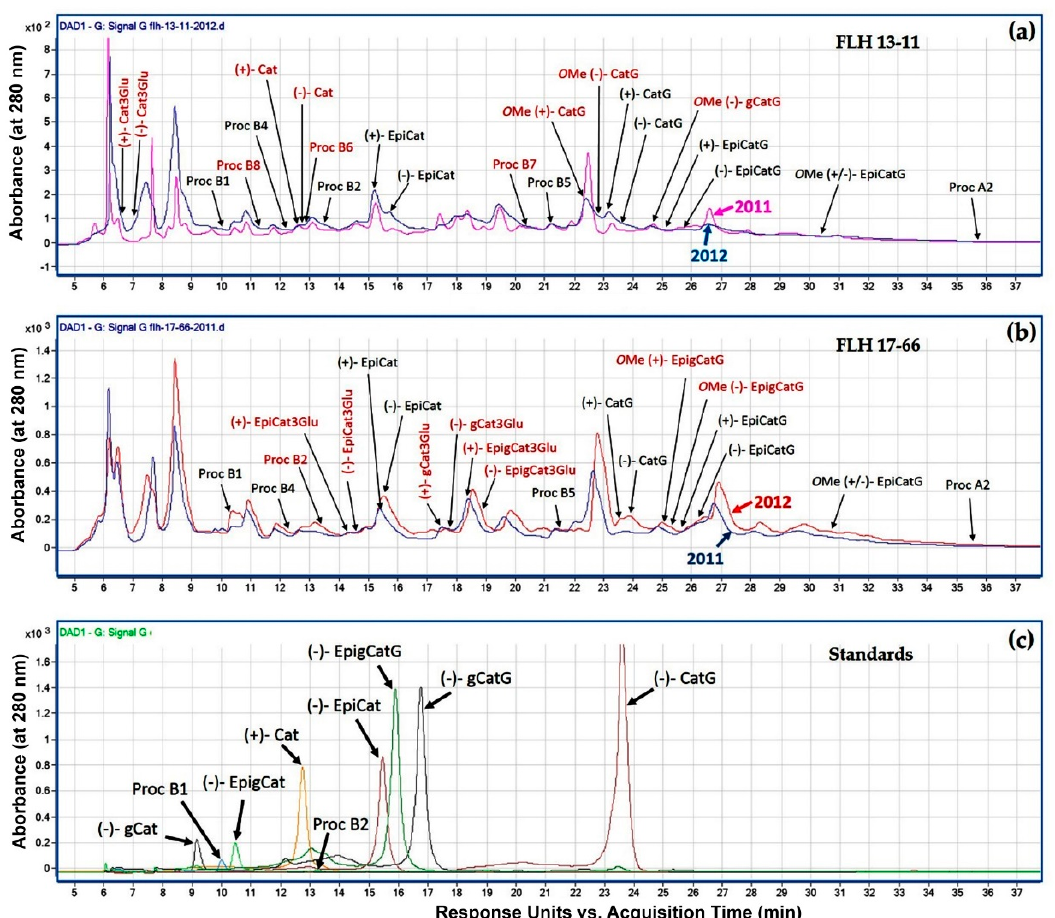
Figure 2. Comparison of metabolite peak profiles between berry extracts of FLH 13-11 and FLH 17-66 in two years and nine standards. Metabolite peaks detected by HPLC were recorded at 280 nm. ( a ) Two chromatograms show peaks annotated to be flavan-3-ols and dimeric PAs in berries of FLH 13-11 from the 2011 and 2012 cropping years. ( b ) Two chromatograms show peaks annotated to be flavan-3-ols and dimeric PAs in berries of FLH 17-66 from the 2011 and 2012 cropping years. ( c ) A chromatogram shows retention times of nine standards including five flavan-3-ol aglycones, two conjugates, and two dimeric PA standards (procyanidin B1 and B2). Compound peaks detected in one variety only and two varieties are highlighted with red and black color,